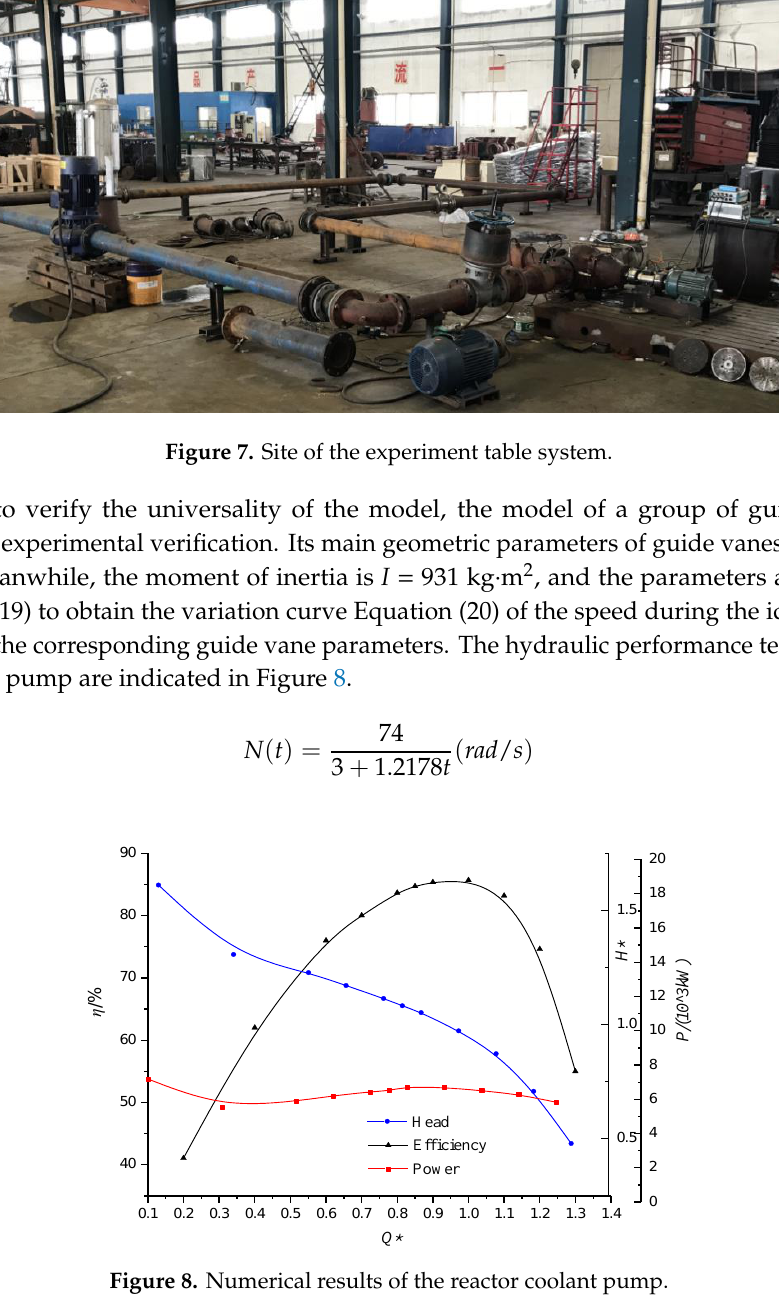
Figure 8. Numerical results of the reactor coolant pump.